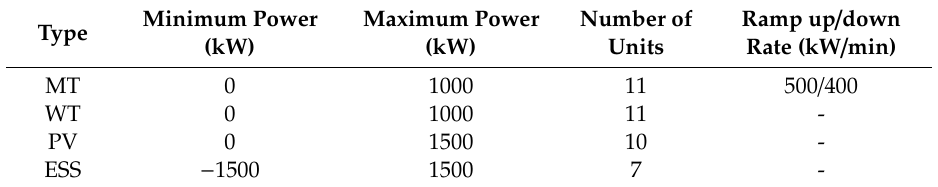
Figure 10. Actual power system in China. Table 6. Capacity parameters.